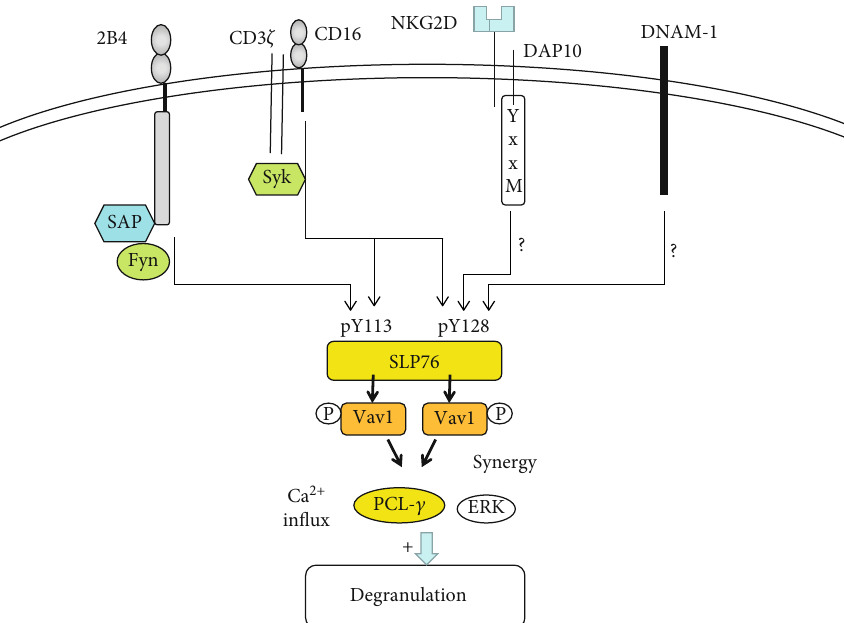
Figure 5: Synergistic activation of coactivation receptors is Vav1-dependent; NK cells promote the cytotoxicity and the secretion of INF- γ by the synergistic e ff ects of NKG2D and 2B4 and 2B4 and DNAM-1. After coactivation receptors engaged, synergistic signals are integrated at SLP76. The phosphorylation of SLP76 induced by 2B4 was Fyn-dependent, whereas the phosphorylation of SLP76 in Y128 induced by NKG2D or DNAM-1 was SYK-independent. In contrast, CD16 can phosphorylate both Y113 and Y128 of SLP76 and su ffi cient to induce NK cell action on itself. Phosphorylated SLP76 associates with Vav1, resulting in phosphorylation of PLC γ 2 and ERK, which promotes degranulation and INF- γ secretion of NK